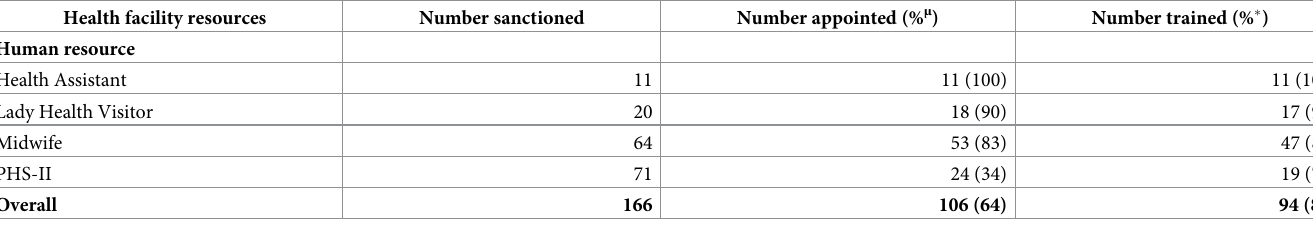
Table 4. Availability of human resource at 20 PEN implementing facilities in Myanmar in 2017–18.